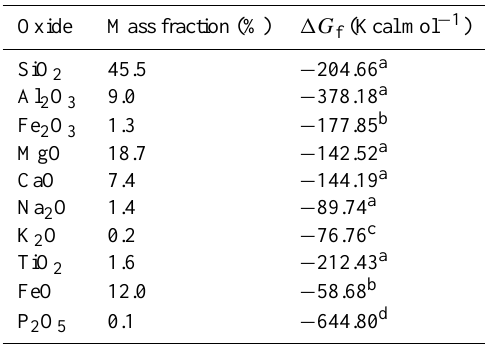
Table A2. CIPW normative mineral assemblage of basalt Mineral